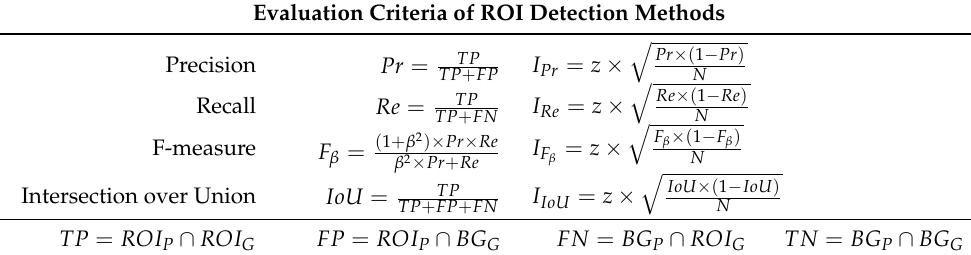
Table 4. Evaluation criteria of ROI detection methods: Precision, Recall, F-measure and Intersection over Union where TP , FN , FP , TN are a number of pixels. ROI P , ROI G are predicted ROIs and ROIs according to the ground truth. BG P , BG G are predicted background and background according to the ground truth. β = 0.3, N = 1156.